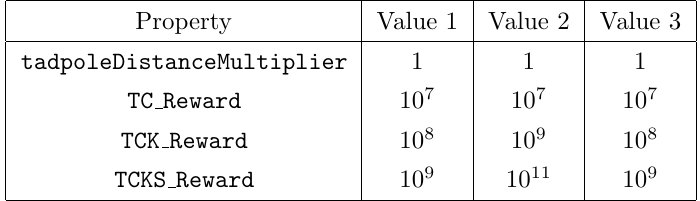
Table 5 . Value assignments for the CONSISTENCY reward function.